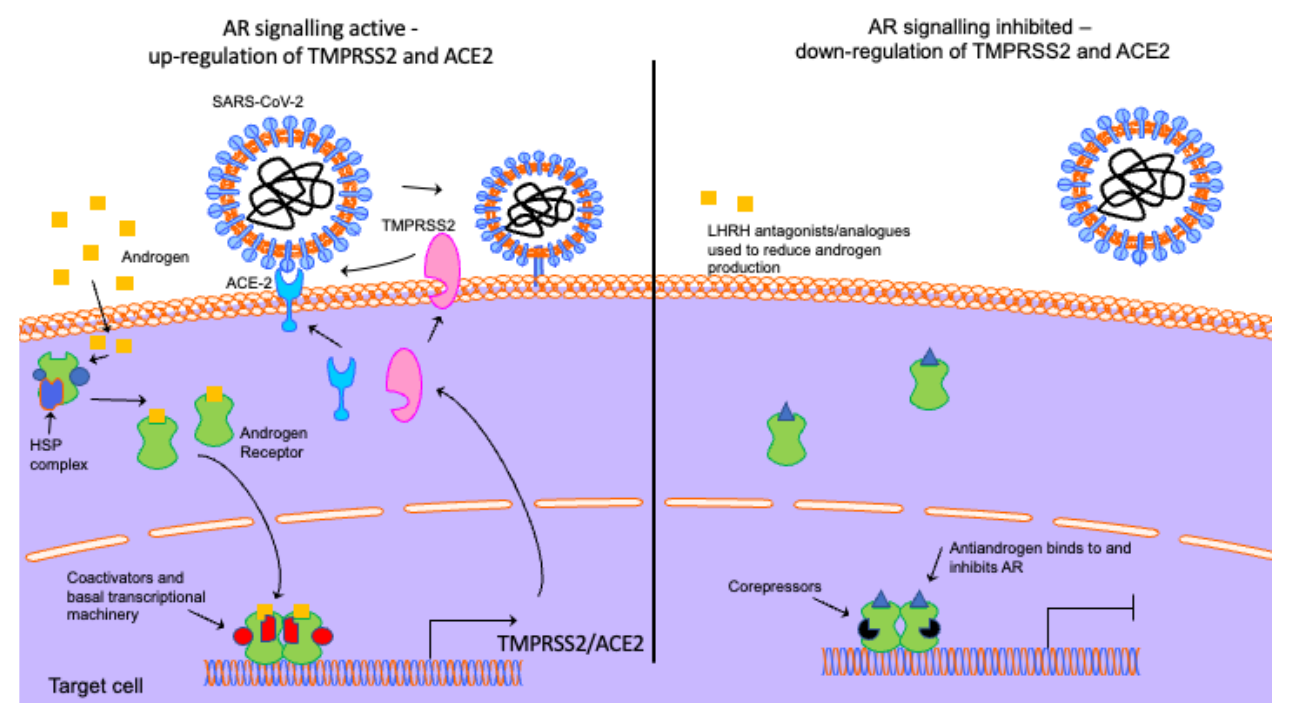
Figure 2. Androgen receptor signalling and how androgen deprivation therapies might block viral uptake. In the absence of androgen, the AR is located in the cytoplasm bound to a heat shock protein (HSP) complex. Ligand binding promotes dissociation of this complex, nuclear localisation and dimerisation. The AR binds to androgen response elements in the regulatory regions of target genes (e.g., TMPRSS2 and ACE2) and, through the recruitment of coactivators and the basal transcriptional machinery, regulates transcription. LHRH analogues/antagonists reduce androgen production to inhibit AR signalling. Antiandrogens bind to and inhibit the AR. The downregulation of AR signalling reduces TMPRSS2 and ACE2 expression, reducing COVID-19 entry. Elements of the schematic are from Motifolio.